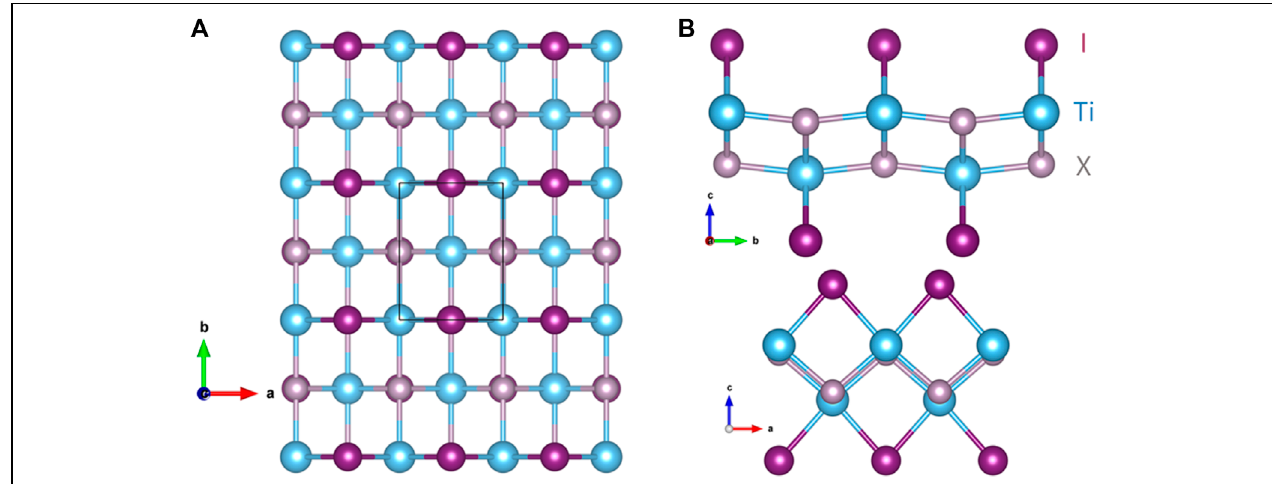
FIGURE 1 | The (A) top view, (B) side view of the crystal structure of single-layer TiXI. The black box in (A) denotes the unit cell. The upper and lower panels in (B) represent the view along the short axis ( a -axis) and the long axis ( b -axis), respectively. The blue, grey, and purple spheres denote the Ti, X, and I atoms, respectively.